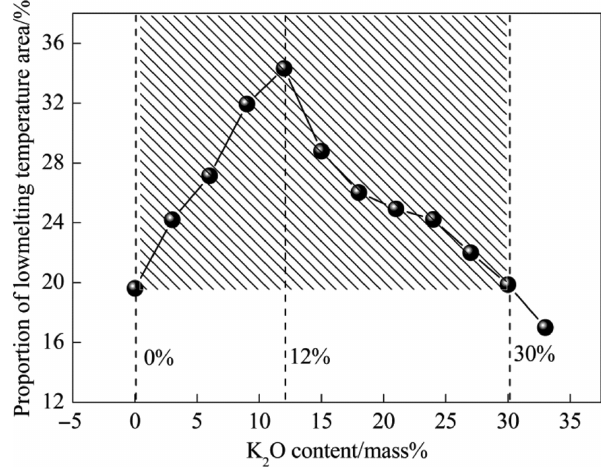
Figure 8: Relation between K 2 O content and the proportion of low melting temperature area in SiO 2 -Al 2 O 3 -MnO-K 2 O phase